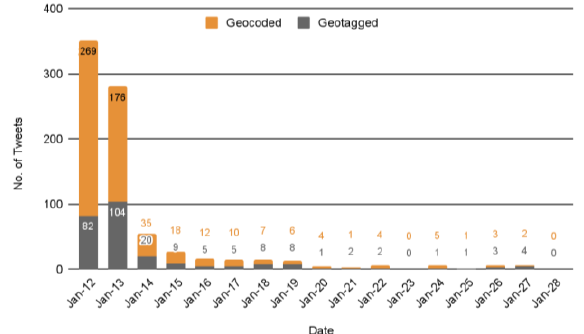
Figure 5. Progression of ashfall-affected locations per day from